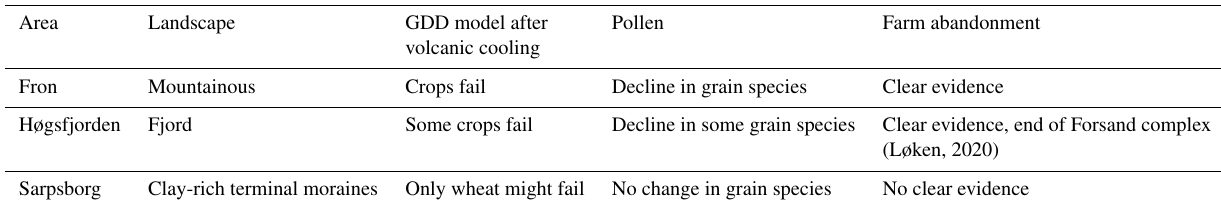
Decline in some grain